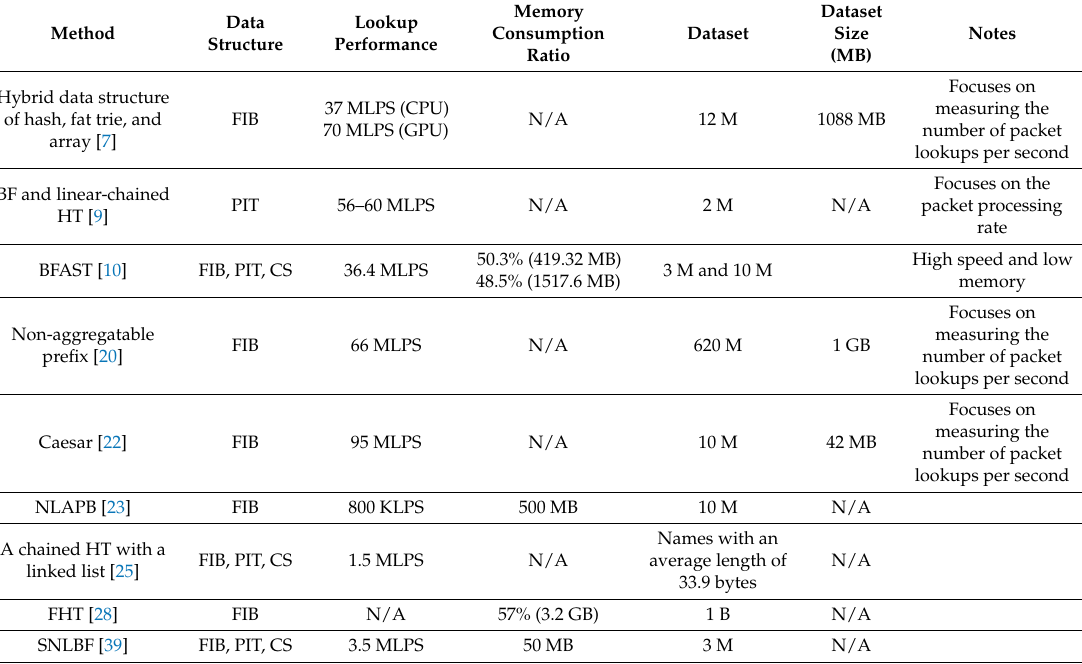
Table 6. Comparison of lookup throughput based on hybrid